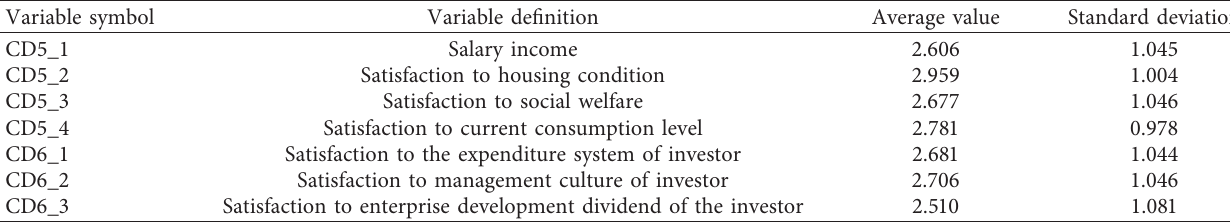
Table 4: Variable definition and score statistics.